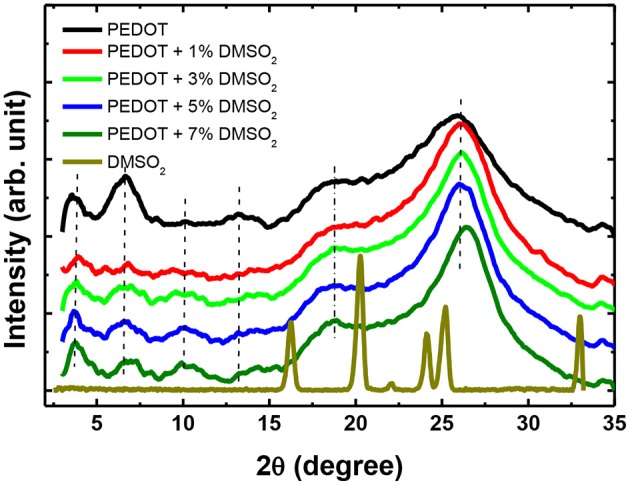
XRD patterns of pristine, DMSO2-doped PEDOT:PSS and DMSO2 crystals.